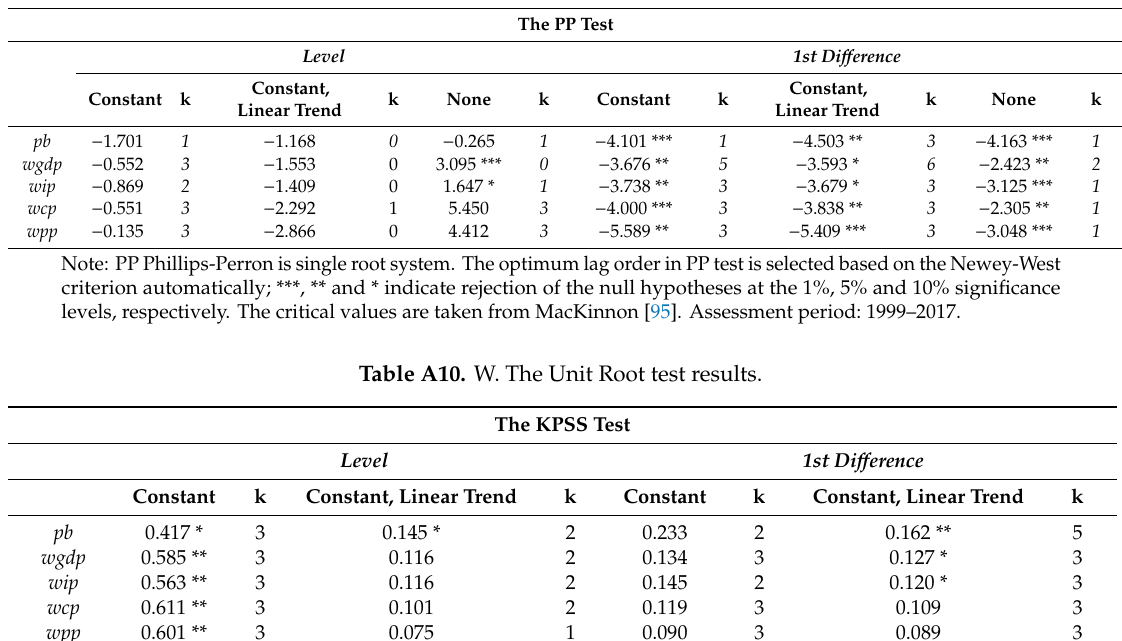
Table A9. W. The Unit Root test results.